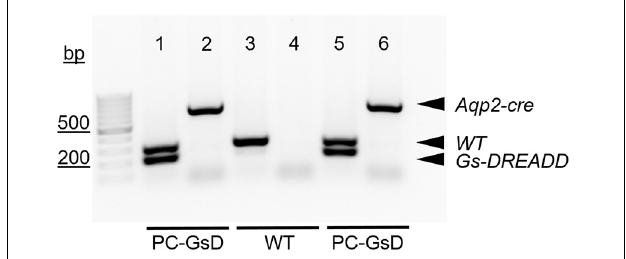
FIGURE 1 | PC-specific GsD mice. Micrograph of a representative gel containing products from genotyping reactions for two PC-specific GsD mice (lanes 1, 2, 5, and 6) and one wild type littermate control mouse (lanes 3 and 4). Products for the Aqp2-cre and GsD transgenes, and the wild type allele are indicated with arrowheads. For presentation purposes, contrast and brightness were adjusted, and the image was inverted (black to white) to maximize clarity without changing content. bp, base